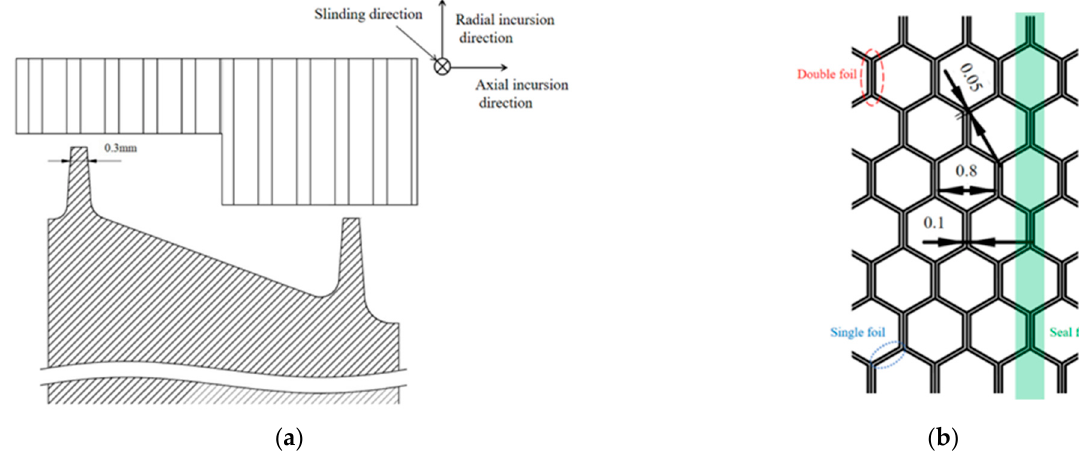
Figure 5. Dimensions of the test sample. ( a ) Test sample of the labyrinth seal fin. ( b ) Test samples of honeycomb.